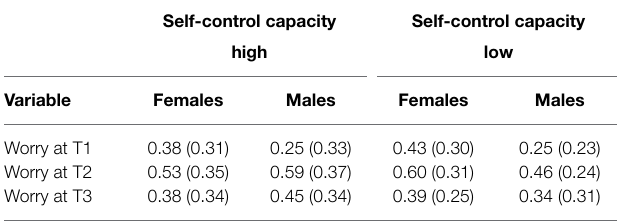
N = 102. Worry = Proportion of the number of worry thoughts in the total number of thoughts. T1/T2/T3 = first/second/third measurement